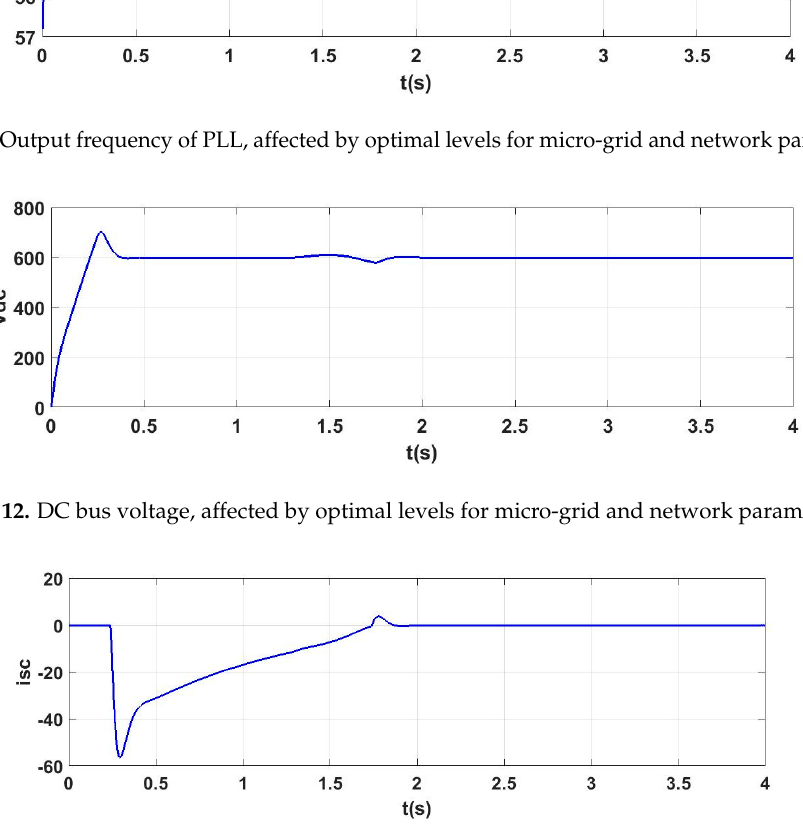
Figure 13. Super-capacitor current, affected by optimal levels for micro-grid and network parameters.